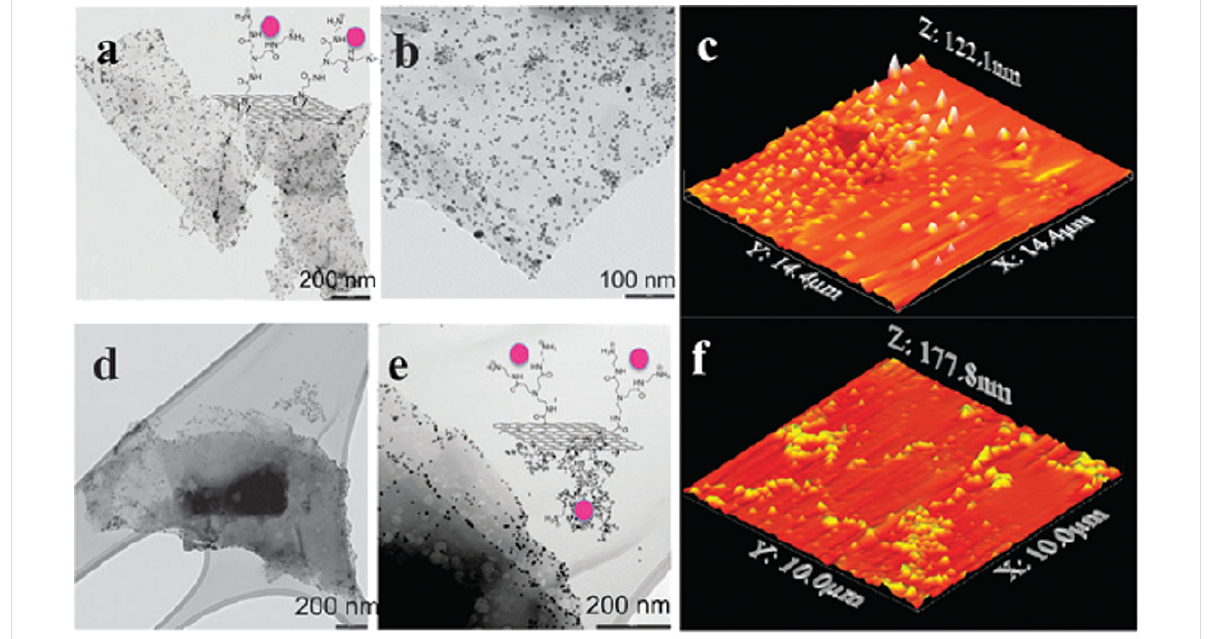
Figure 7: TEM and AFM micrographs after the addition of Au NPs for the identification of reactive sites against 1,3-dipolar cycloaddition (a–c) and amidation reaction on carboxylic groups created during the sonication process (d–f). Reproduced with permission from [42], copyright 2011 The Royal Society of